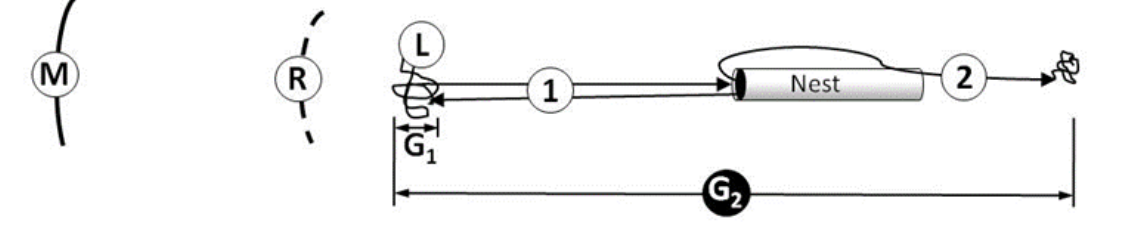
F IGURE 1. Graphic model depicting the spatial patterns of a bee’s home range, two foraging trips and resulting pollen -mediated gene flow (not to scale). Labels are: M=maximum flight range, R=realized home foraging range, L= localized foraging bout in a flower patch, 1 & 2 = sequential foraging trips by nesting bee, G 1 = small genetic neighbourhood resulting from patch fidelity on one foraging trip, G 2 = pollen flow distance resulting from carryover into a sequential foraging